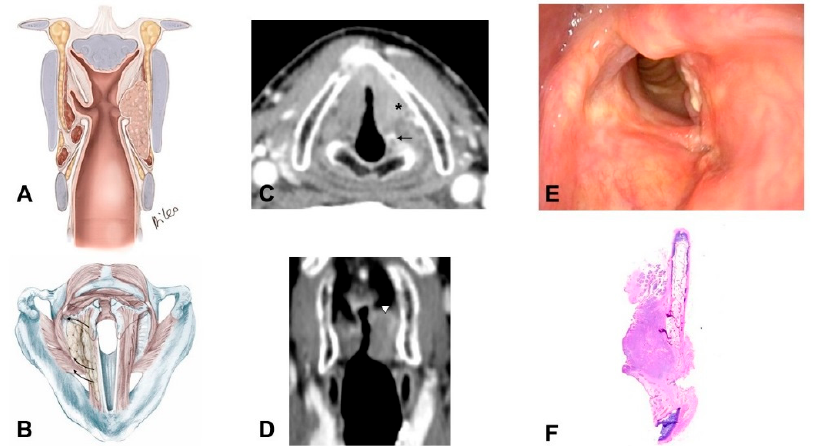
Figure 3. Pattern 2: Glottic carcinoma invading the inferior paraglottic space and extending down to